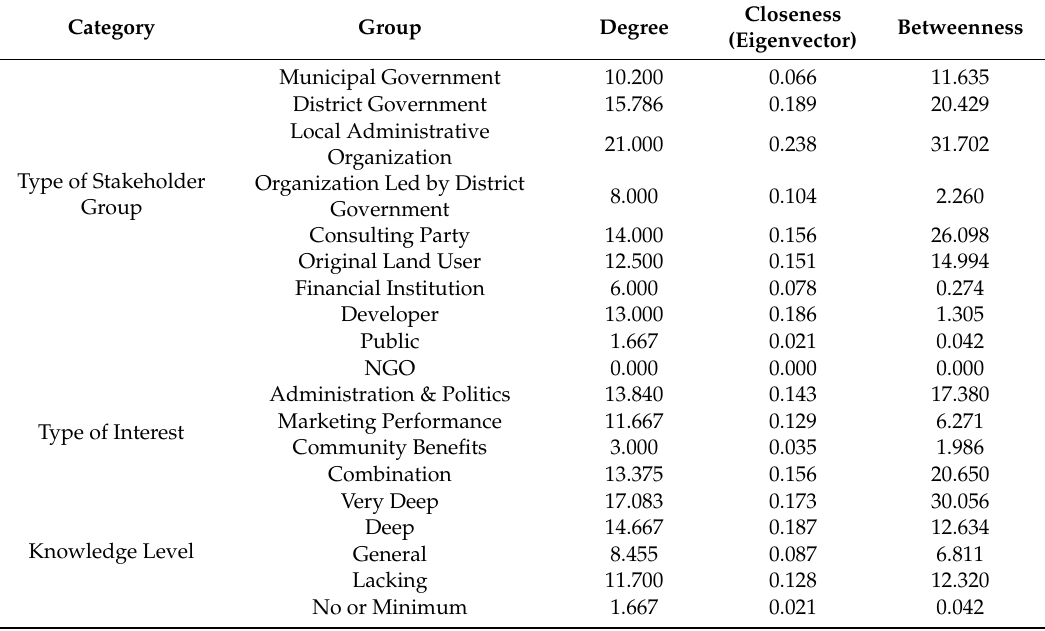
Table 4. Group centrality